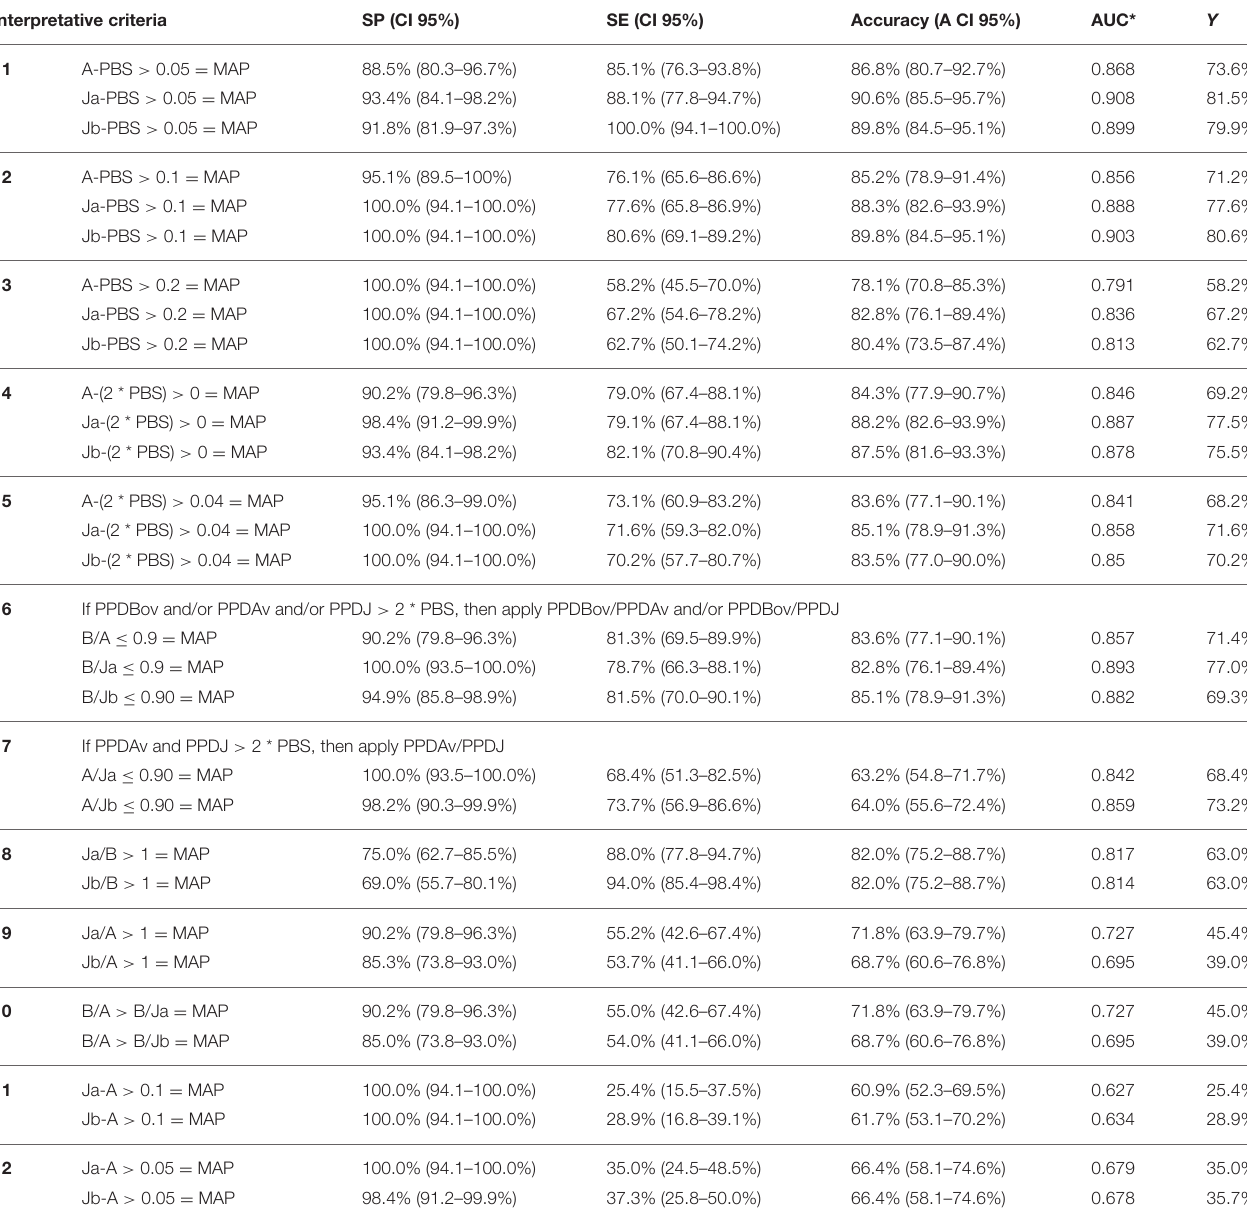
TABLE 2 | Specificity and sensitivity values obtained with 12 interpretative criteria of the IFN- γ test and cutoff values applied in the study for the diagnosis of Mycobacterium avium subsp. paratuberculosis (MAP) infected cattle. Interpretative